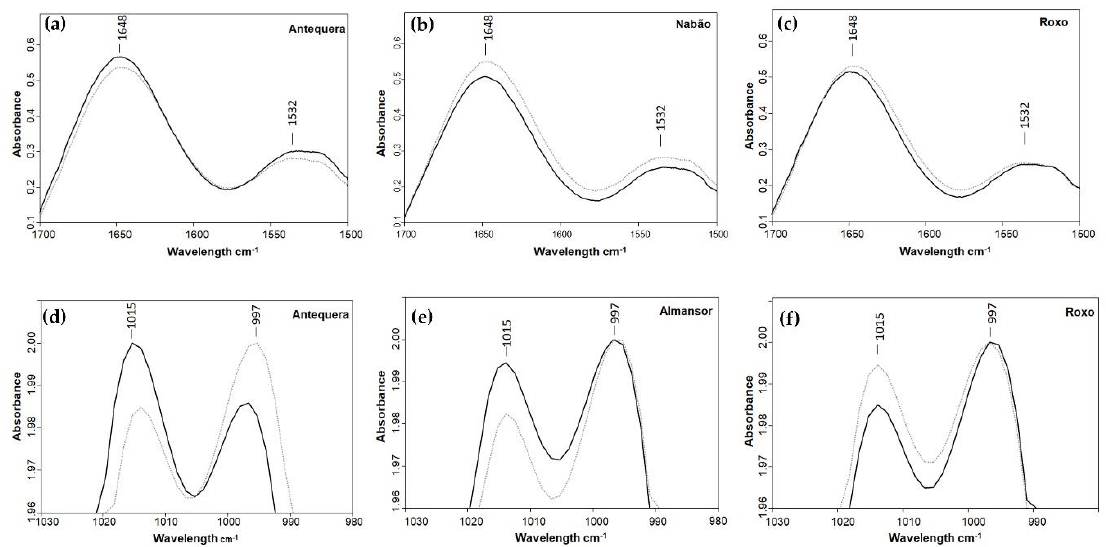
Figure 3. ATR-FTIR spectra of wheat milled grains representing different variations between control (dark lines) and HT treated (light lines) plants obtained in amide I and II bands associated with protein ( a–c ), and in 1015 and 997 cm −1 bands associated with starch ( d–f ).